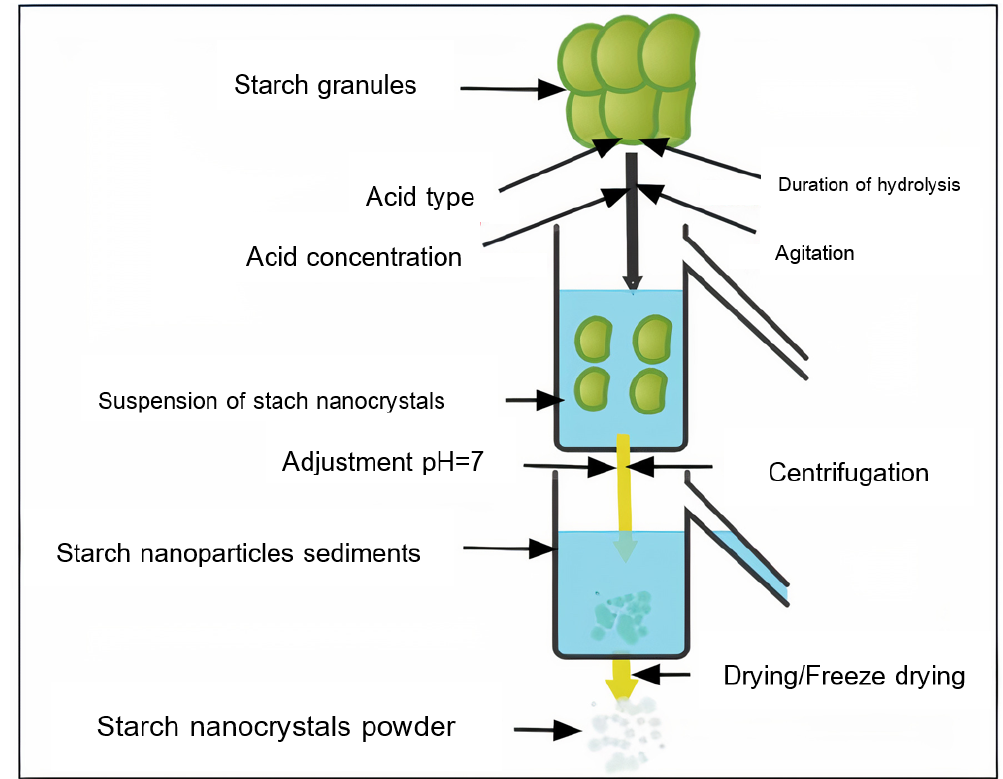
Figure 3. Acid hydrolysis for preparation of starch nanoparticles.